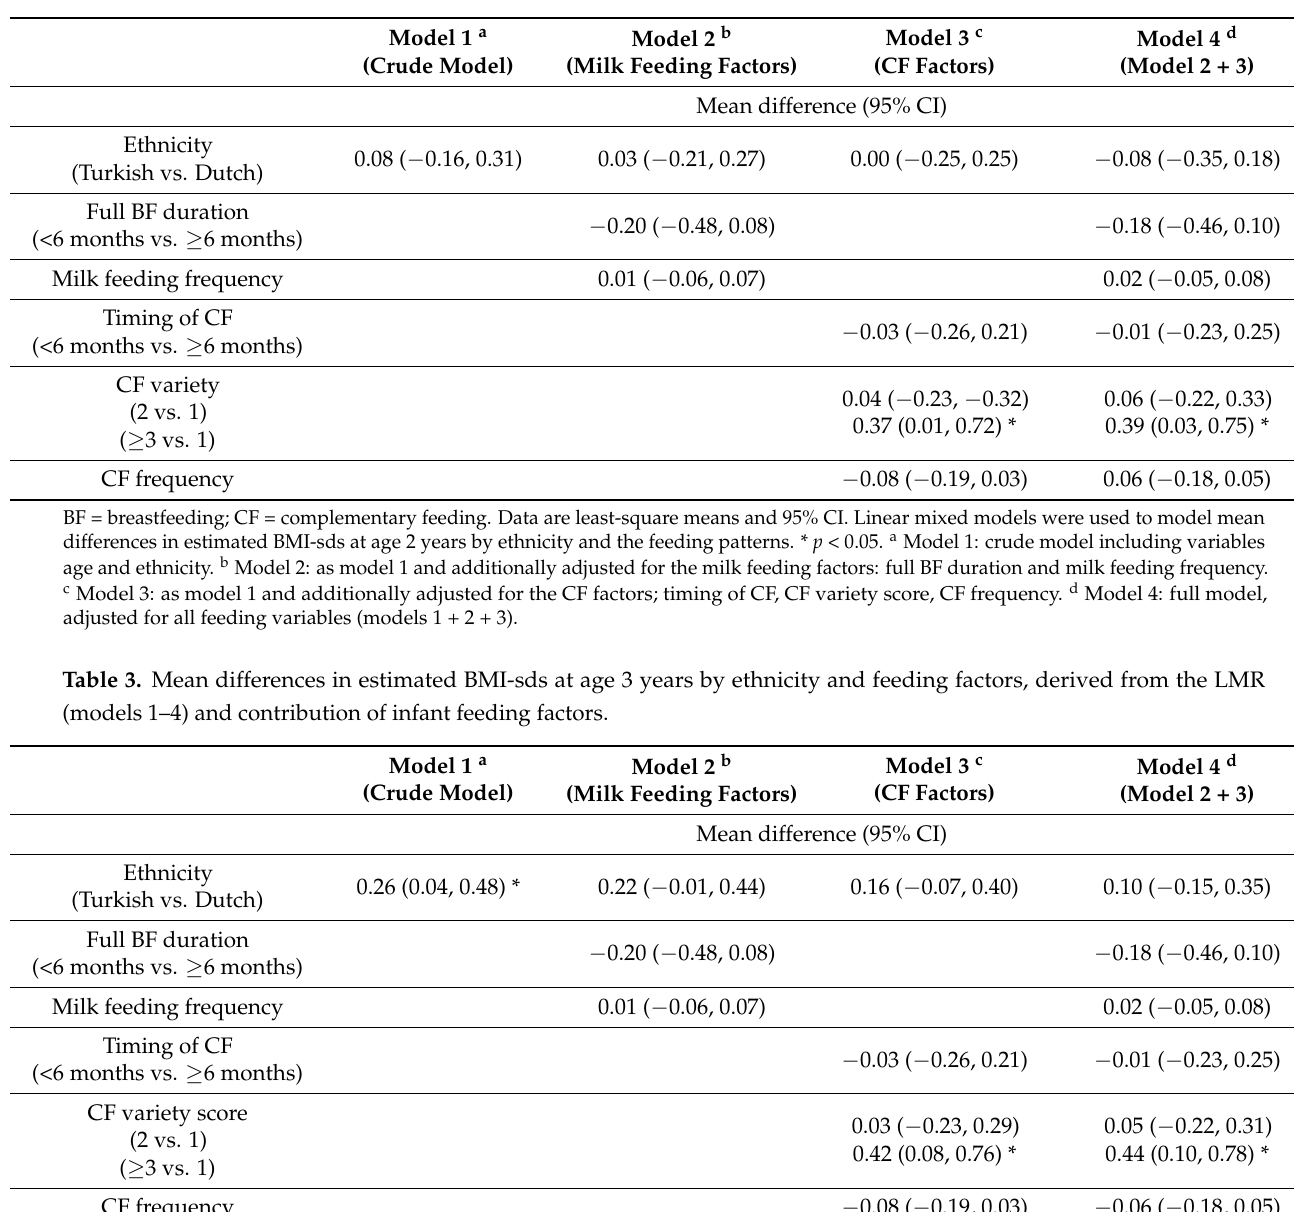
Table 2. Mean differences in estimated BMI-sds at age 2 years by ethnicity and feeding factors, derived from the LMR (models 1–4) and contribution of infant feeding factors.